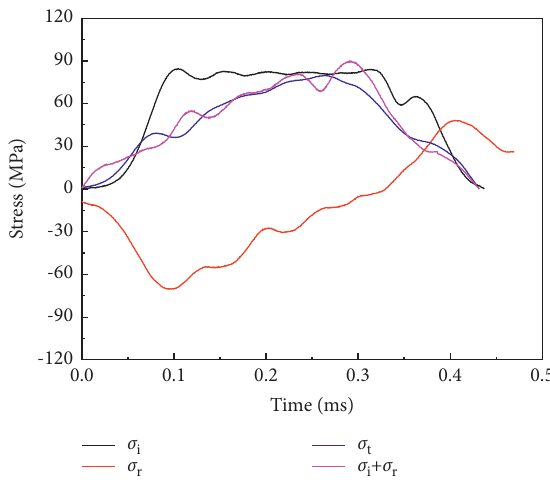
Figure 3: Dynamic stress equilibrium of sandstone. Table 2: Experimental results of sandstone under cyclic impact